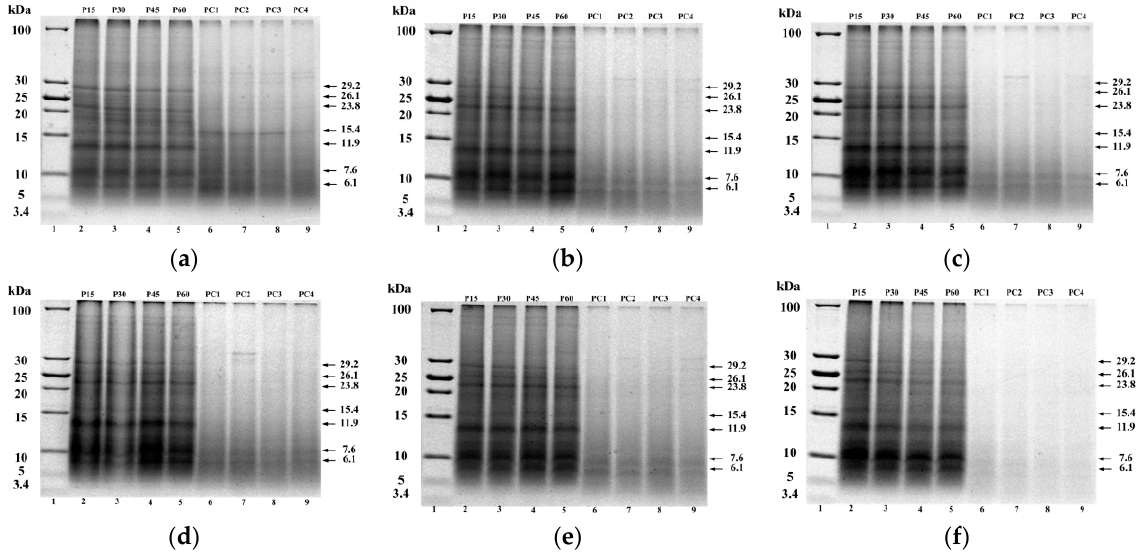
Figure 6. Tricine-SDS-PAGE of ball-milled CFP at different digesting time. ( a – f ), Tricine-SDS-PAGE image of CFP (0, 2, 4, 6, 8, and 10 min) after in vitro gastric and gastro duodenal digestions with simulated. Lane 1: molecular mass marker, lane 2–5: 15 min (P15), 30 min (P30), 45 min (P45), 60 min (P60) of gastric digests; lane 6–9: 1 h (PC1), 2 h (PC2), 3 h (PC3), 4 h (PC4) of gastro duodenal digests (60 min of gastric followed by 4 h of duodenal digestion).